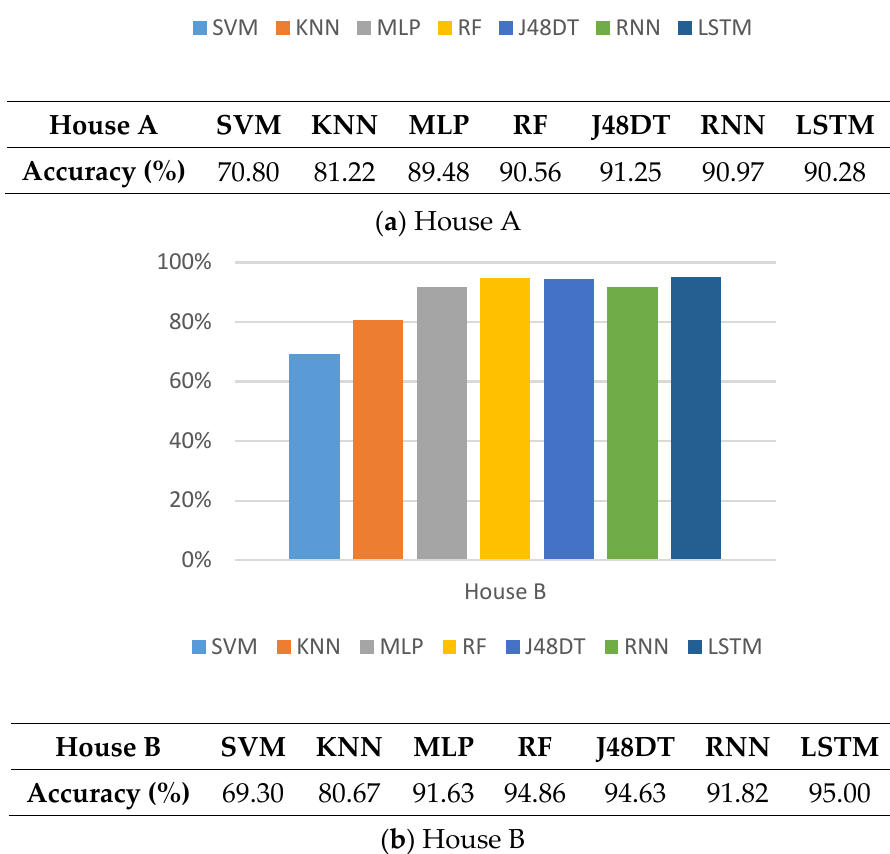
Figure 7. Comparison on accuracy of different methods.